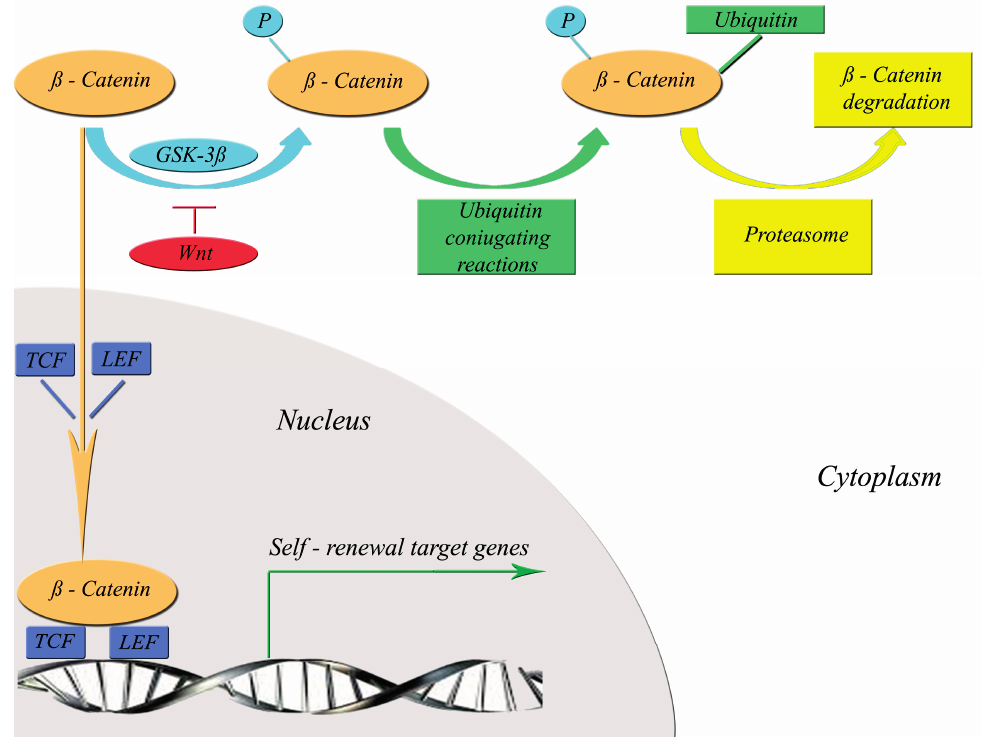
Figure 1. Signaling network of Wnt/ β -catenin regulating the expression of self-renewal genes in cancer stem cells. In the presence of Wnt, GSK-3 β is inhibited and β -catenin can translocate from the cytoplasm into the nucleus with consequent activation of self-renewal target gene transcription. Abbreviations: GSK-3 β , glycogensynthasekinase-3 β ; TCF, T cell factor; LEF, lymphoid enhancer factor; Wnt, wingless-related integration